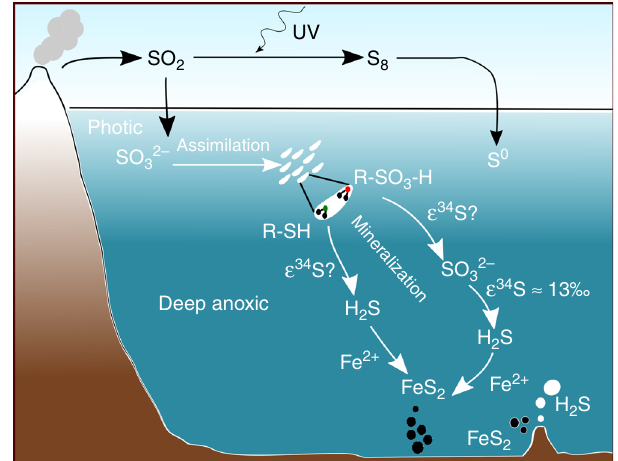
Fig. 1 Archean sulfur cycle with contribution from organic sulfur (OS). Mineralization of OS serves as a source of both oxidized (up to + 4) and reduced sulfur in the ferruginous deep-water column and sediments. In the Neoarchean, the availability of free oxygen would increase the role of sulfate ( +